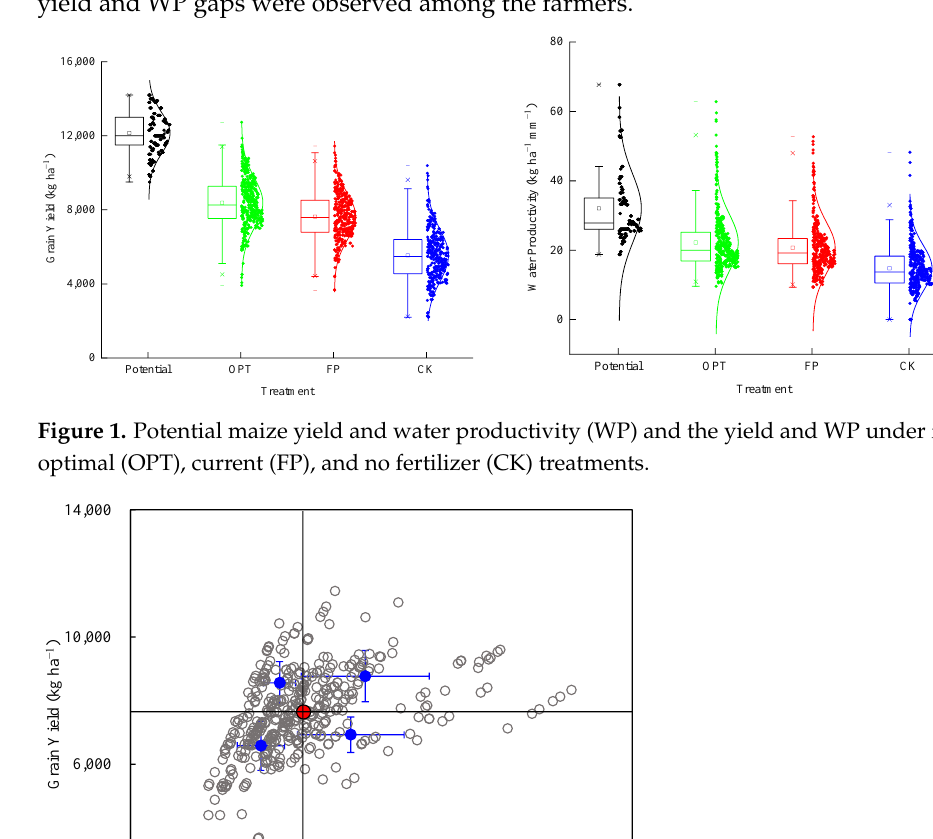
Figure 2. Grain yield and WP of various farming groups.